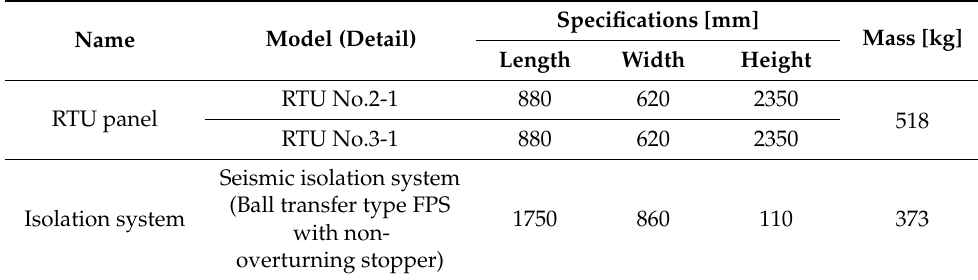
Table 1. Description of units under